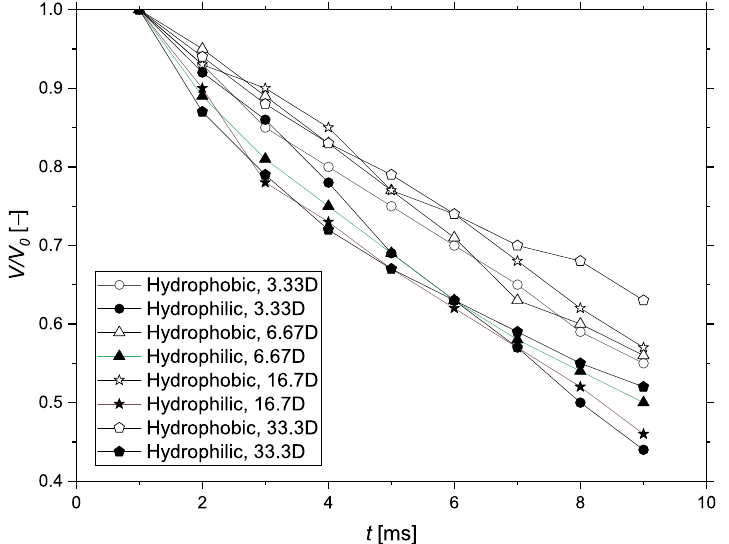
Figure 11. Variation in the dimensionless velocity of the projectile with time under different water